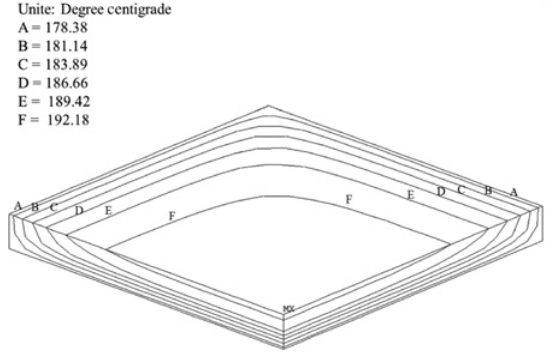
Figure 8: Temperature contour of one eighth of the laminate.